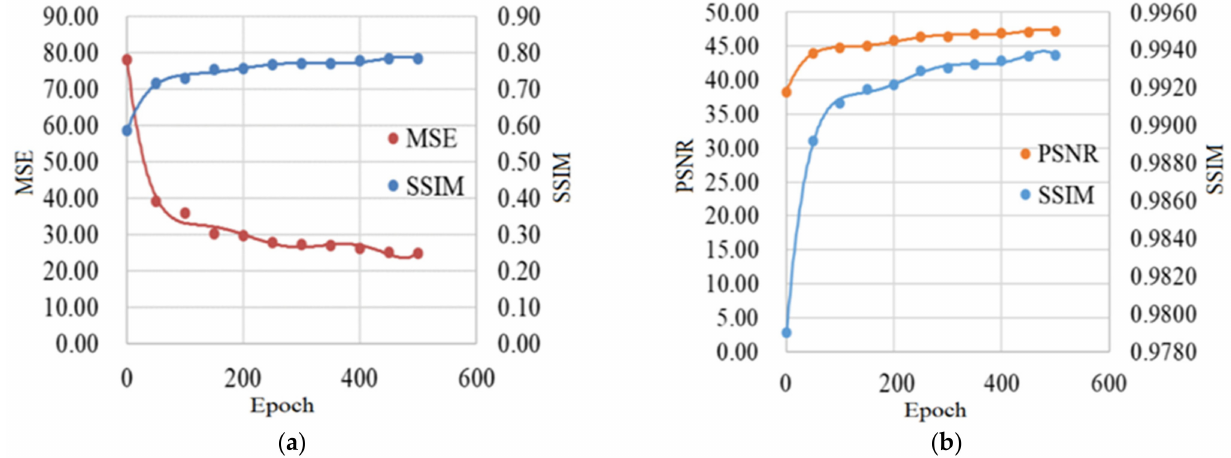
Figure 7. Relevance experiment results. ( a ) The SSIM and MSE of I R_S and I R_G ; ( b ) the SSIM and PSNR of I B and I B_G